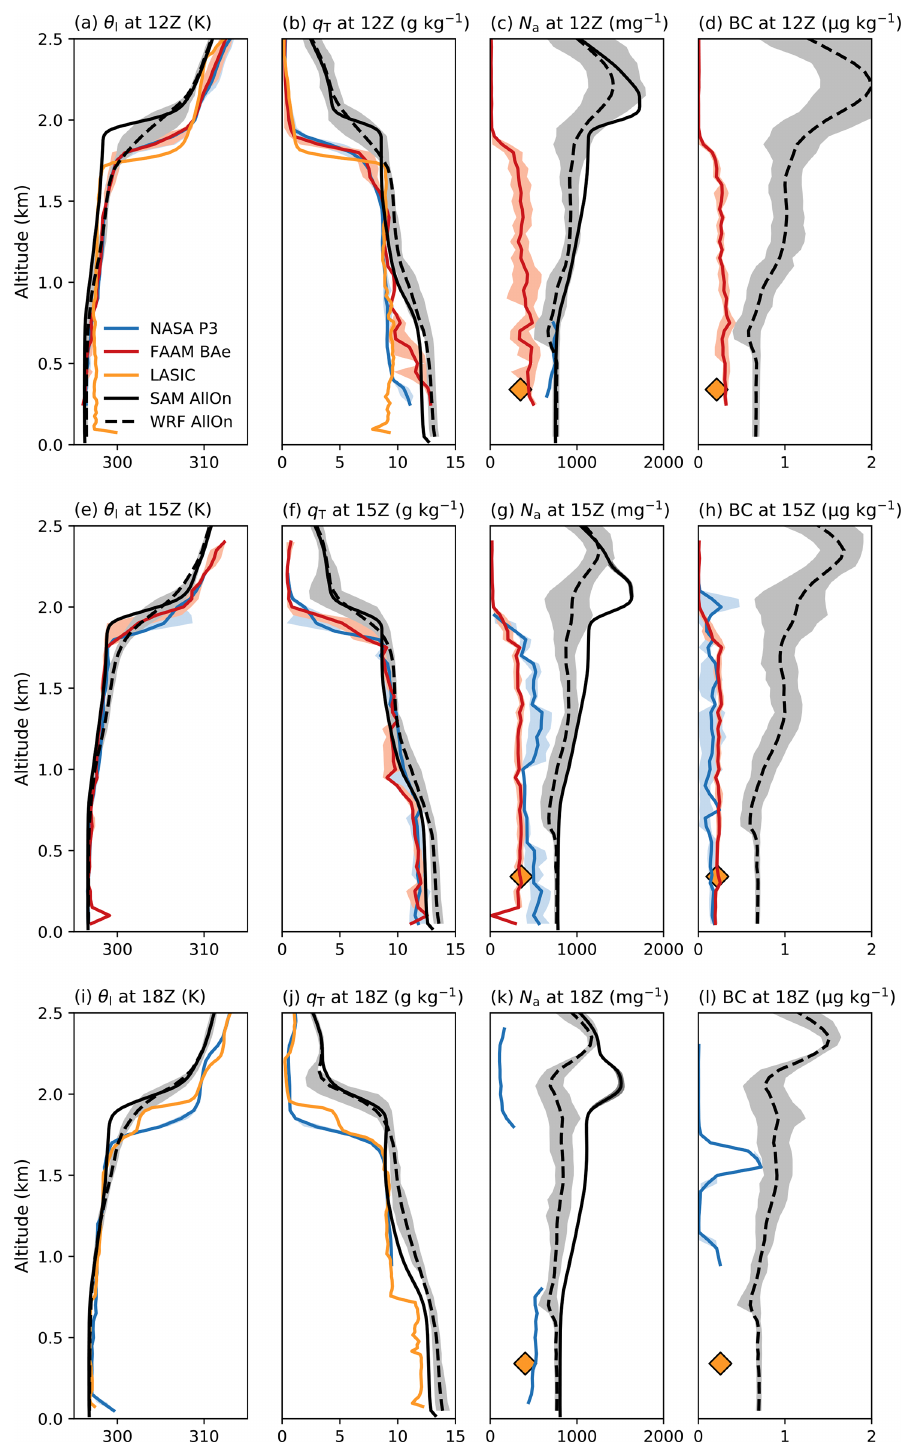
Figure 19. Comparison of model output with co-located ORACLES, CLARIFY, and LASIC observations for three time periods. Liquid water potential temperature, total water mixing ratio, accumulation-mode aerosol number concentration, and black carbon (BC) mass concentration are shown in (a–d) ∼ 12:00, (e–h) 15:00, and (i–l) 18:00UTC, respectively, where data are available. Lines represent the mean and shading the interquartile range at each altitude for the models, flights, and radiosondes. Ground station data are represented as a diamond marker for the mean